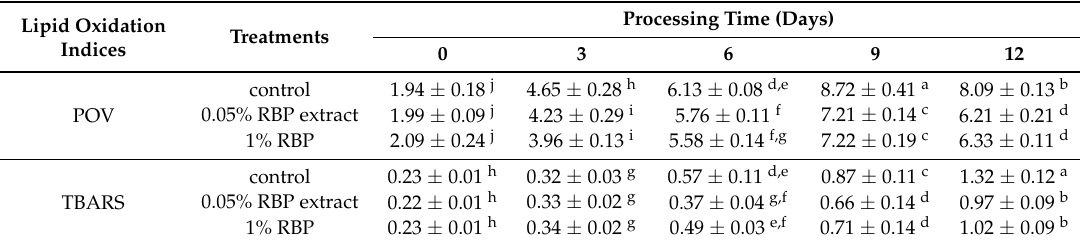
Table 3. The effect of RBP on lipid oxidation during processing of